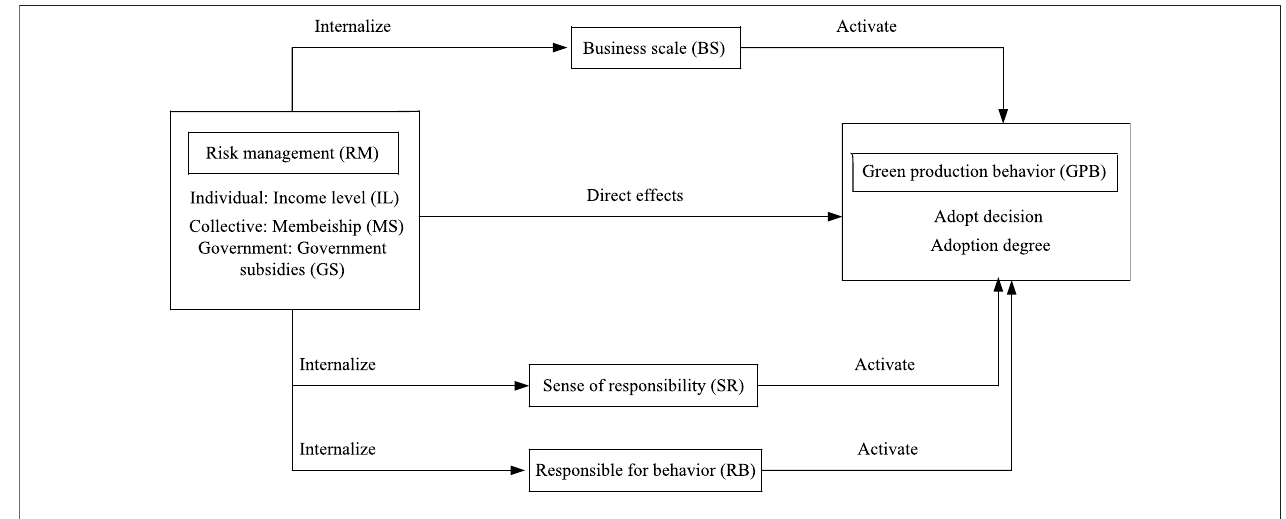
FIGURE 1 | Theoretical